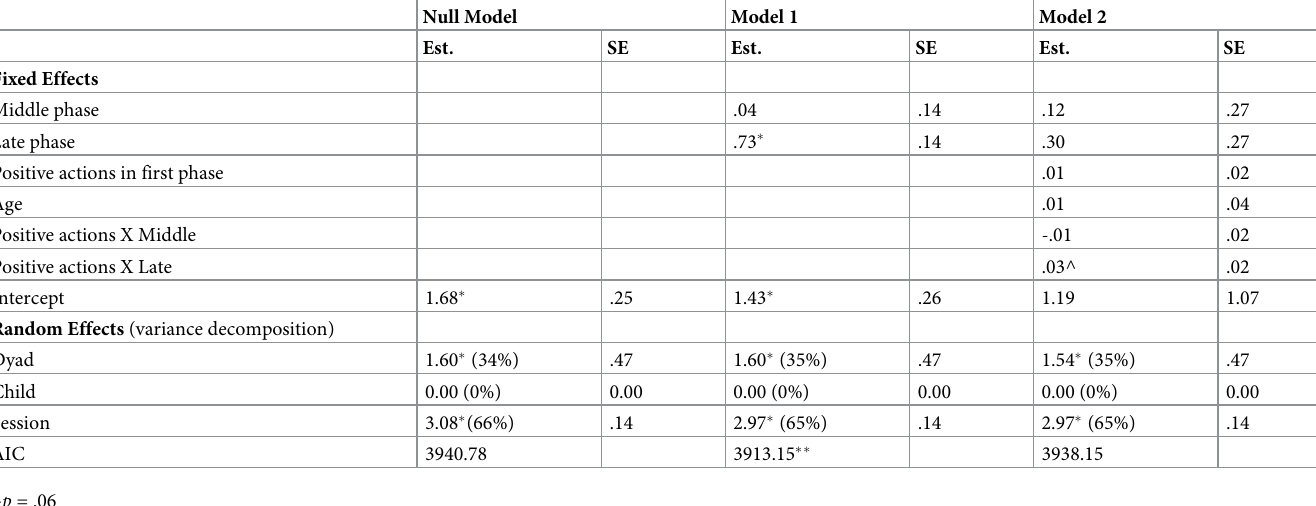
Table 2. Cross-classified multilevel model examining frequency of game sequences with phase, positive actions in the first phase, and age as